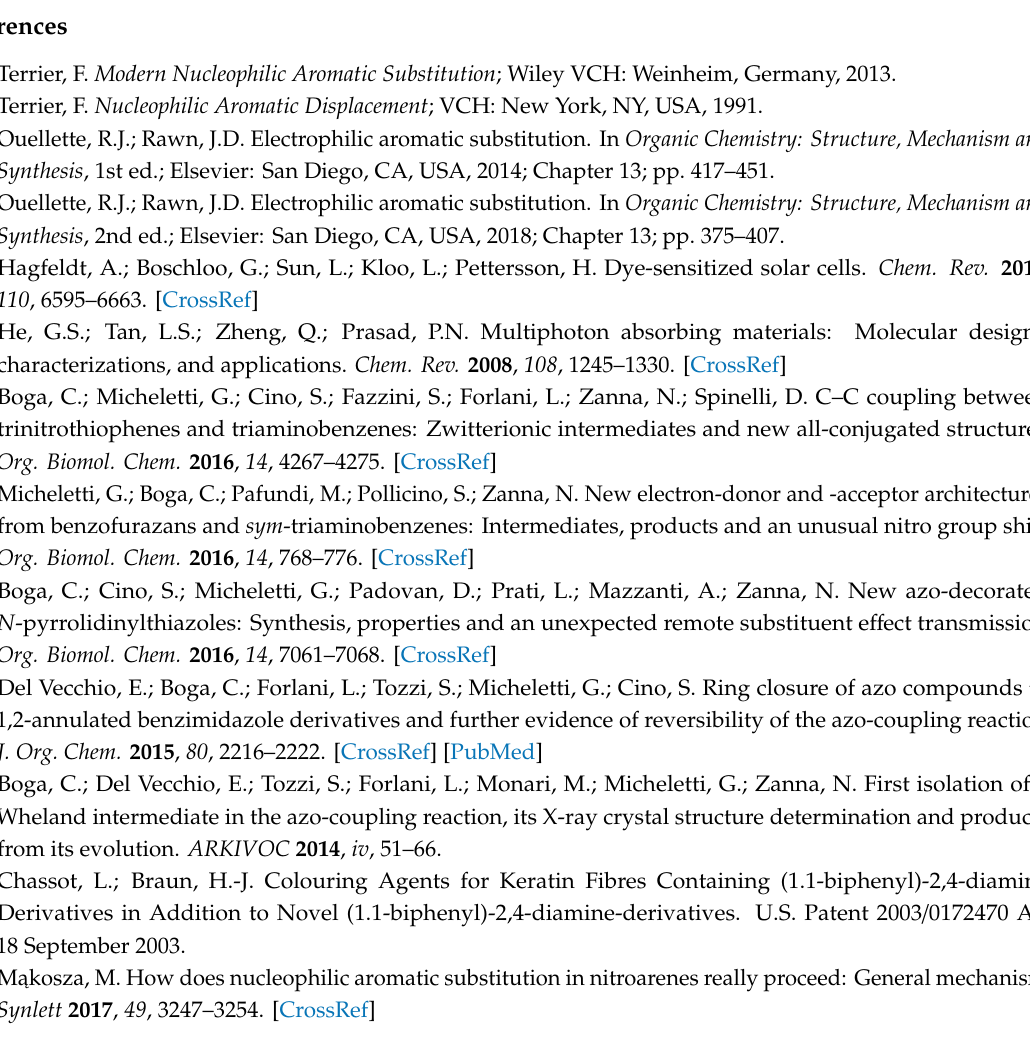
Supplementary Materials: The following are available online, Figure S1. 1 H-NMR spectrum in CDCl 3 of compound 4 ; Figure S2. 13 C-NMR spectrum in CDCl 3 of compound 4 ; Figure S3. DEPT spectrum in CDCl 3 of compound 4 ; Figure S4. ESI-MS spectrum of compound 4 ; Figure S5. FT-IR spectrum of compound 4 ; Figure S6. UV / Vis spectrum of compound 4